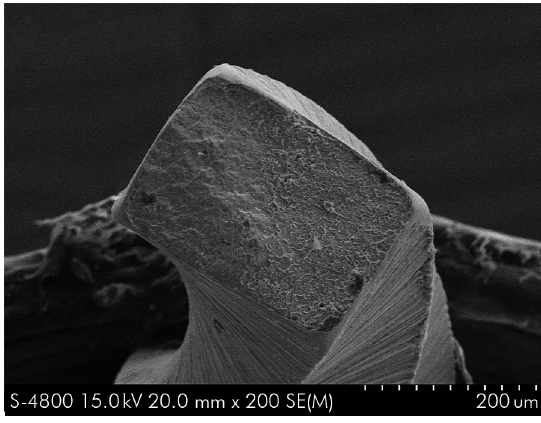
Figure 6. Scanning electron micrographs of the cross surface of the fractured ProTaper Next files from a 45° canal.